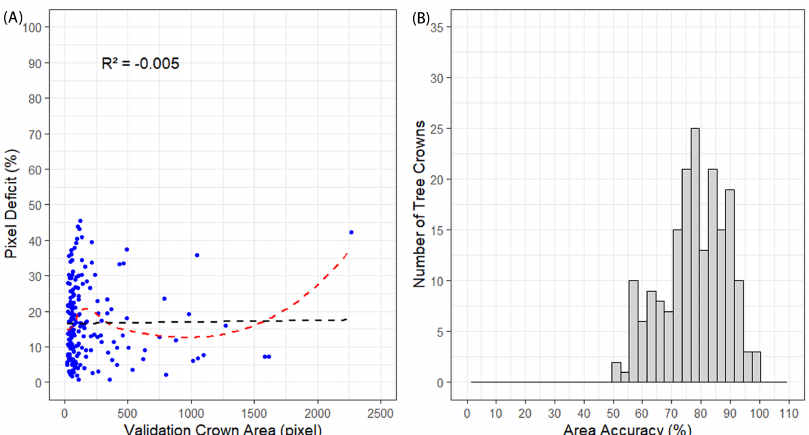
Figure 11. ( A ) The association between the validation crown area (in pixels) and the pixel deficit. The red dashed line represents a local polynomial to fit the graphic variables. The black dashed line is the approximation between pixel deficit and the crown area, and the coefficient of determination ( R 2 ) from this approximation is equal to − 0.005; ( B ) The frequency of the right percentage of the tree crown area, or, in other words, the area accuracy, was estimated by the Mask R-CNN. The mean pixel excess was 25.2% and the number of segmented crowns within this group was 196 (49.6% from the total of 395 detected crowns). There was no association between the validation tree crown size and pixel excess (see Figure 12A). The average area of tree crowns with pixel excess was 25 m 2 . The black dashed line in Figure 12A correspond to an approximation between the pixel excess and the tree crown area (from the evaluation set) by a linear model with a R 2 equal to 0.01. A total of 11 (2.8%) tree crowns had no pixel deficit or excess. The average area accuracy within the tree crowns with pixel excess was equal to 92.1%, and 191 (97.4% from 196 with pixel excess) had an area accuracy over 70%, see Figure 12B.